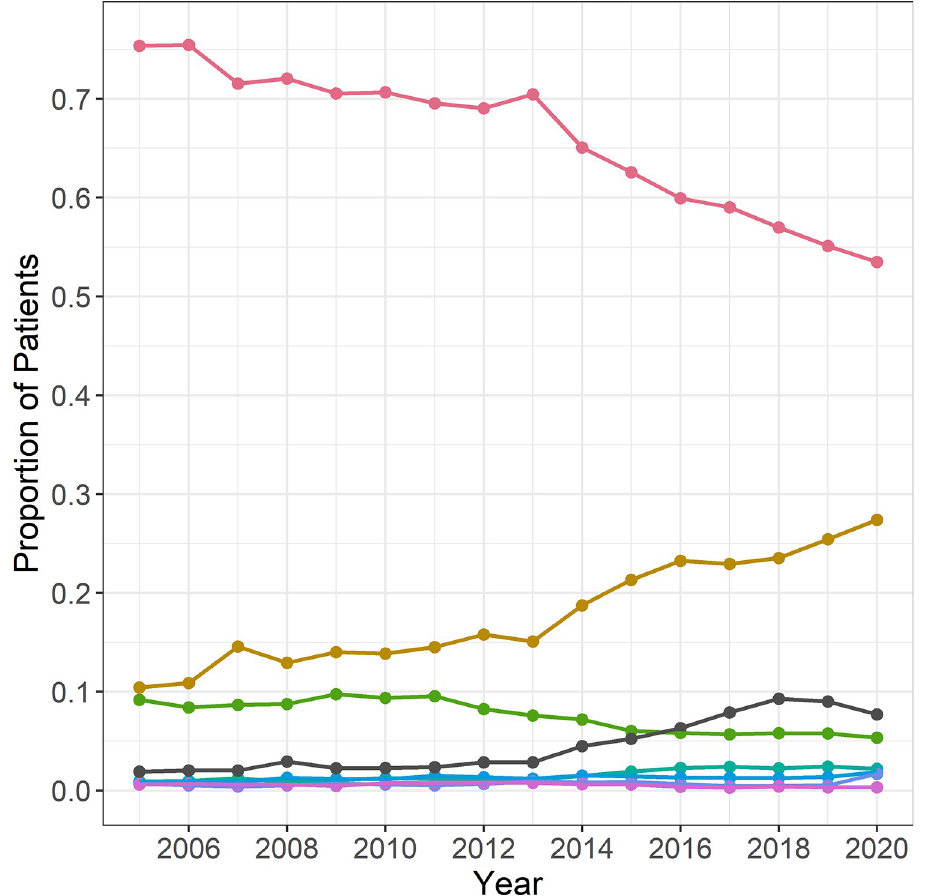
Fig 1. Types of airway procedures used from 2005 to 2020. (oral intubation = red, supraglottic airway device = brown, nasal intubation = green, mask ventilation = turquoise, tracheal cannula = blue, double lumen intubation = purple, jet ventilation =